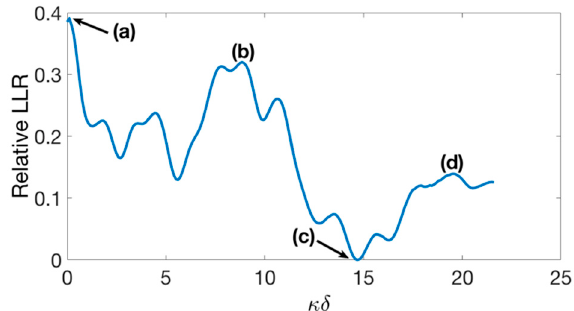
Figure 9. Stand-off, given in number of wavelengths, vs. relative loss of lateral resolution for 445 kHz PDMS-based 144 ◦ axicon lens. ( a ) δ = 0 mm; ( b ) δ = 20.5 mm; ( c ) δ = 34 mm; and ( d ) δ = 45.25 mm.